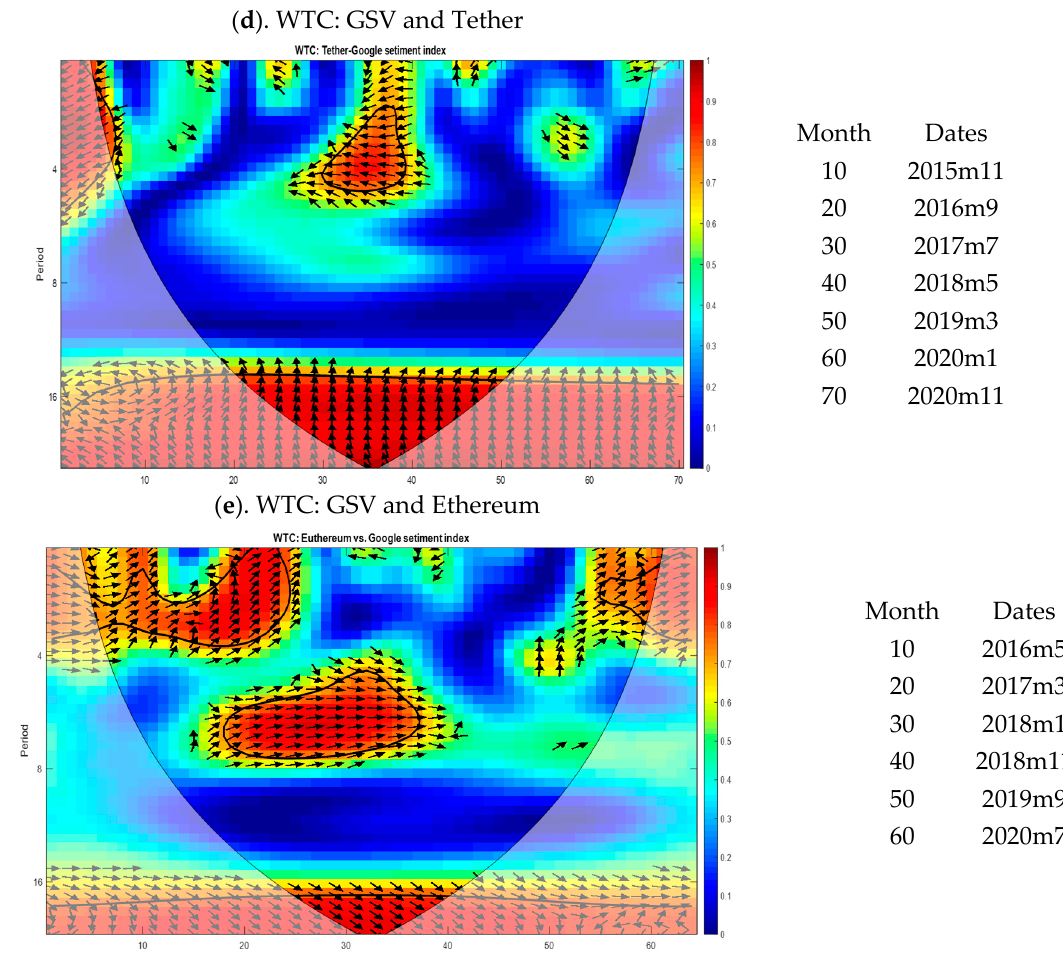
Figure 5. Wavelet coherency between cryptocurrencies and Google search volume over time and across scale bands. The black contour recognizes the regions in which the spectrum is significant at the 5% level against red noise. The cone of influence (COI) is designated by the lighter shade, which delimits high ‐ power regions. The horizontal and vertical axes denote time and scale bands, respectively.